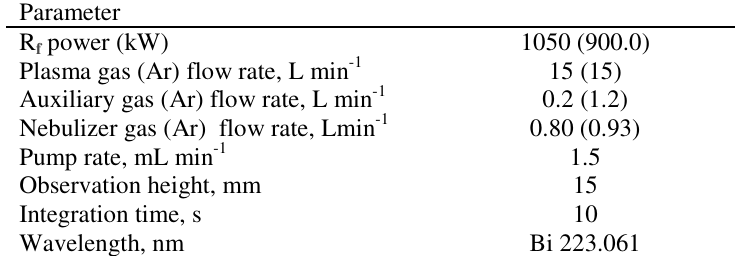
Table 1. ICP-OES operational conditions and wavelength (nm) for bismuth determination *